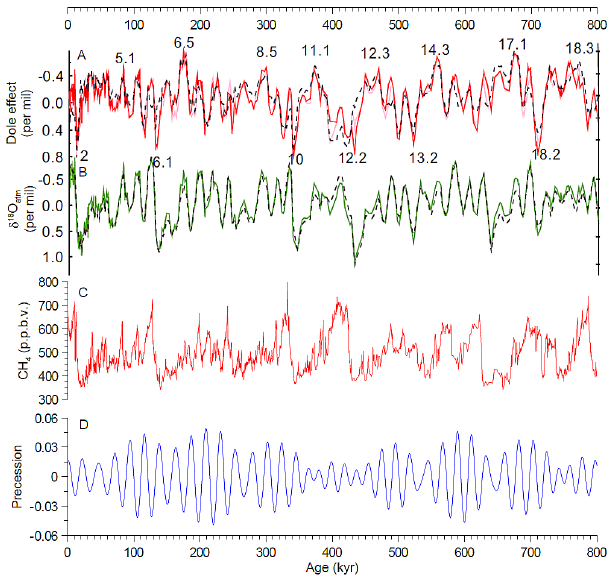
Figure 5. Proxies related to the GM in Antarctic ice cores. (a) Dole effect; (b) δ 18 O atm , based on the composite Antarctic ice cores (Landais et al., 2010; dotted lines in (a) and (b) represent princi- ple components PC2 and PC1, respectively); (c) CH 4 concentration in EPICA/Dome C (Loulergue et al., 2008); (d) precession period-